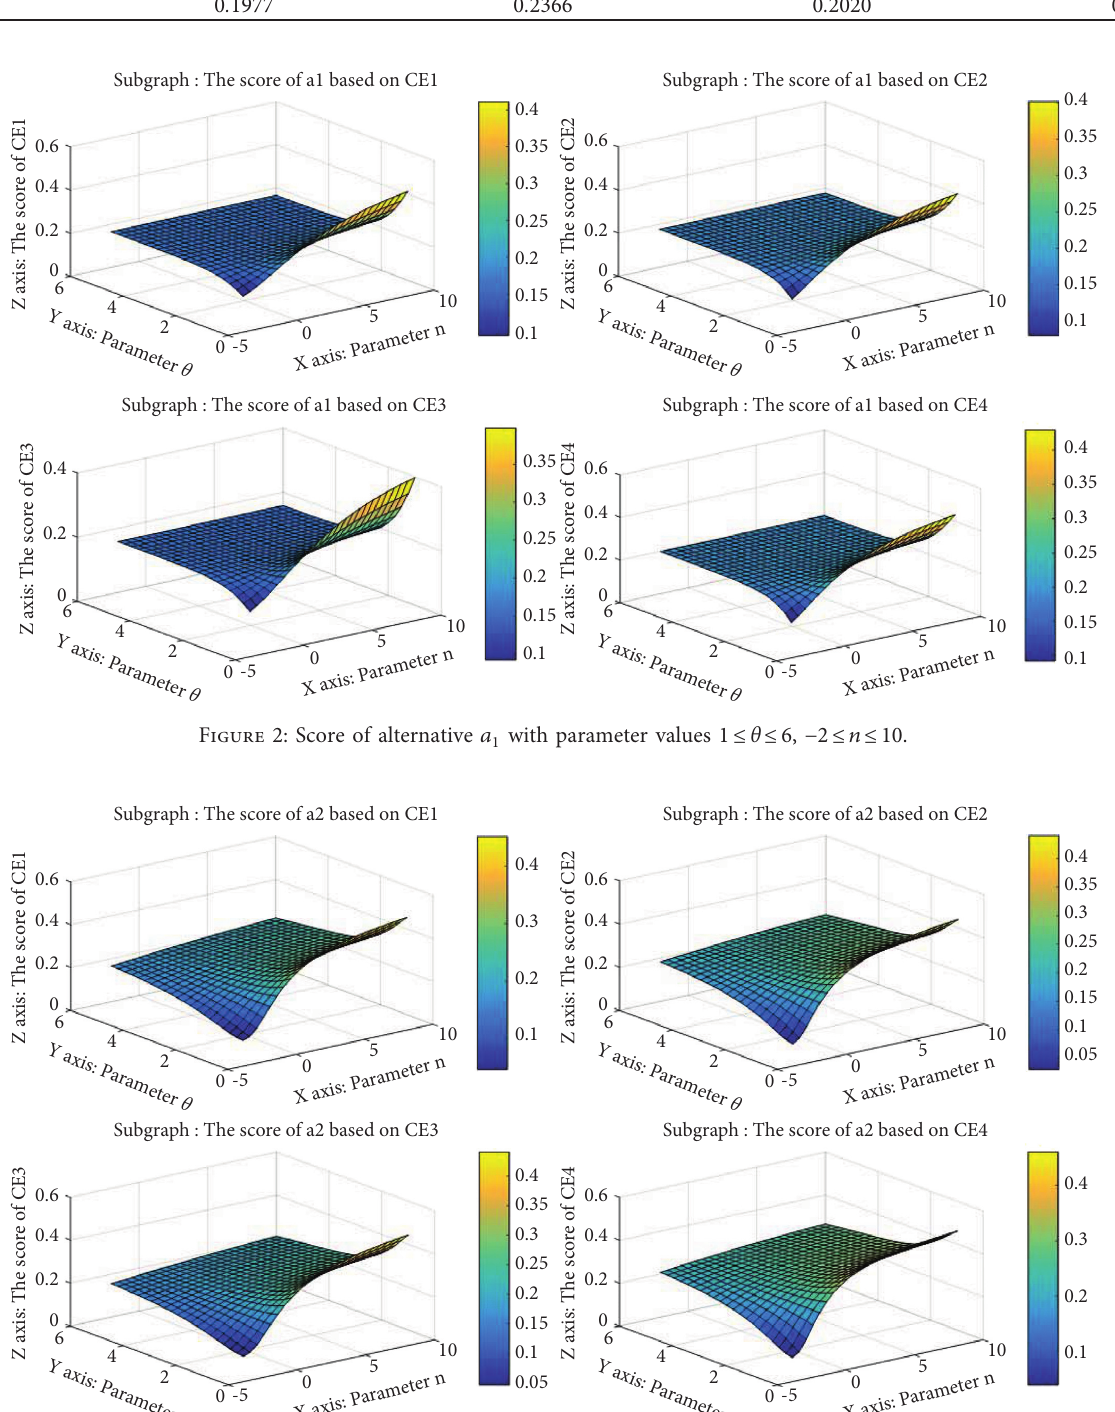
based on parameter values 1 ≤ θ ≤ 6, − 2 ≤ n ≤ 2